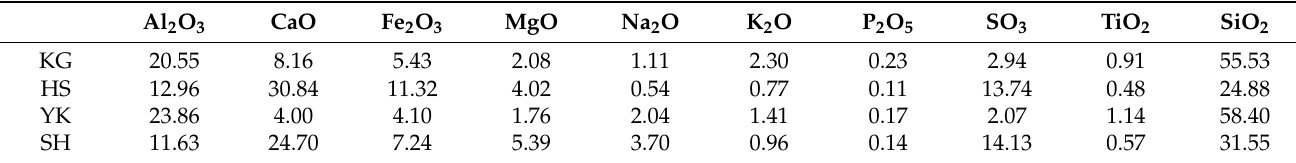
Table 2. Ash composition of four low-rank coals (%).